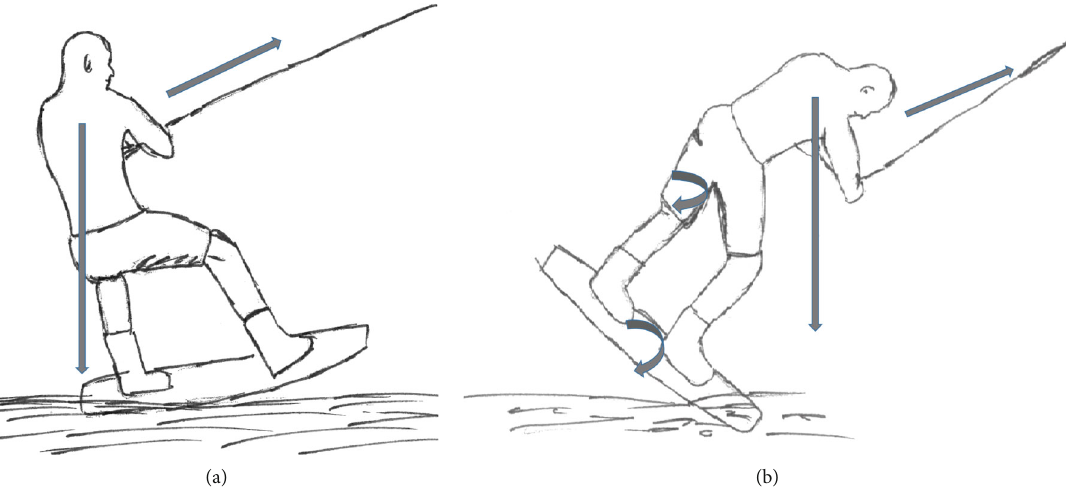
Figure 3: (a) Normal wakeboard ride with forward pulling forces and weightbearing of the backford foot (goofy footed); (b) submerge front tip of the wakeboard with pulling forces to the front and nearly fully extended back foot leg with rotational forces of the wakeboard and subsequently of the back foot